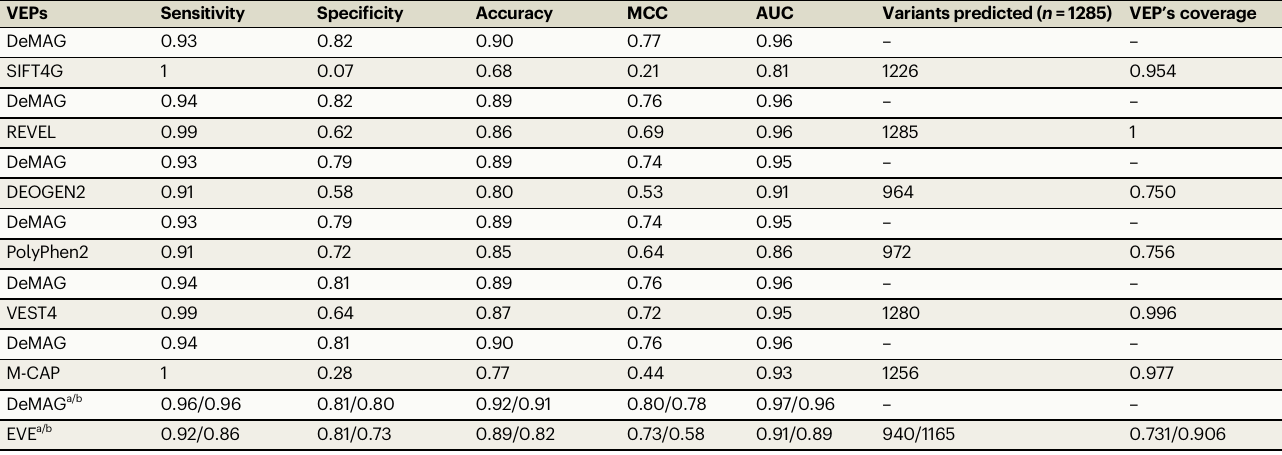
Table 1 | DeMAG outperforms other VEPs on clinical variants